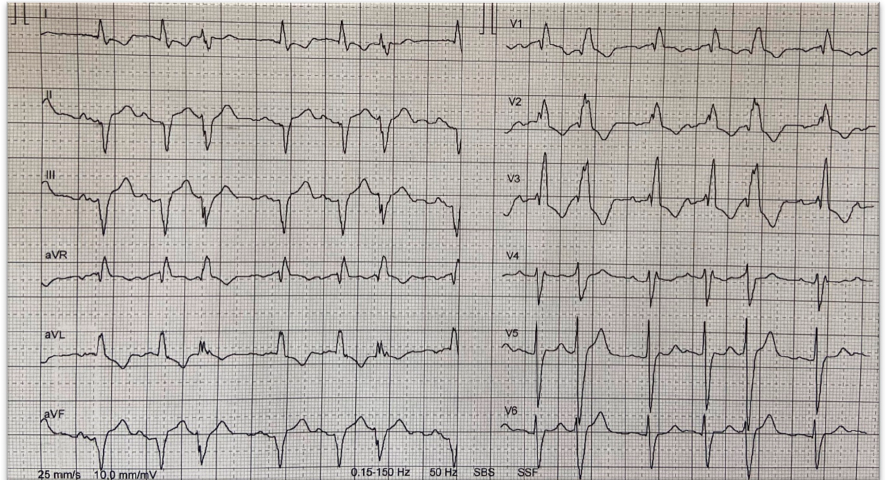
Figure 2. 12-lead surface ECG of a 53-year-old male patient with wtATTR demonstrating 1st degree AV block, left anterior hemiblock, right bundle branch block and supraventricular ectopic beats.